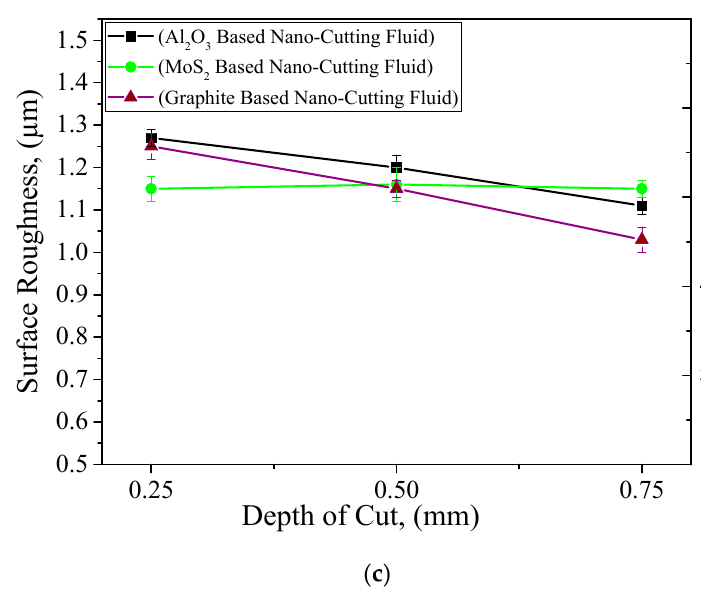
Figure 8. Effect of cutting parameters on surface roughness. ( a ) Cutting Speed, where f = 0.15 mm/rev & a p = 0.50 mm; ( b ) Feed Rate, where Vc = 250 mm/rev and a p = 0.50 mm; ( c ) Depth of Cut, where Vc = 250 mm/rev and f = 0.15 mm/rev.